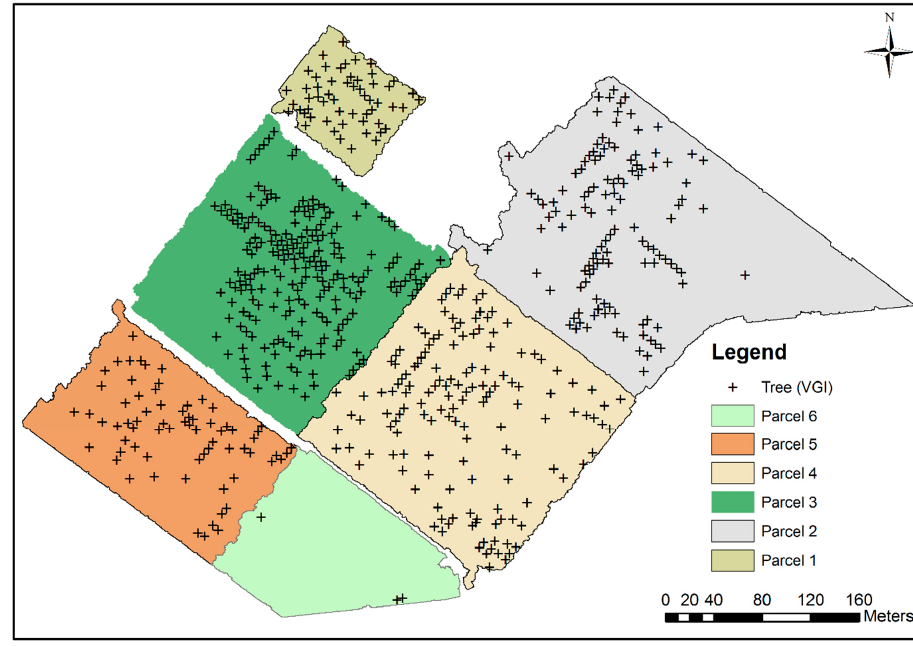
Figure 4. Map of the crowdsourced trees over the parcels of the study area.